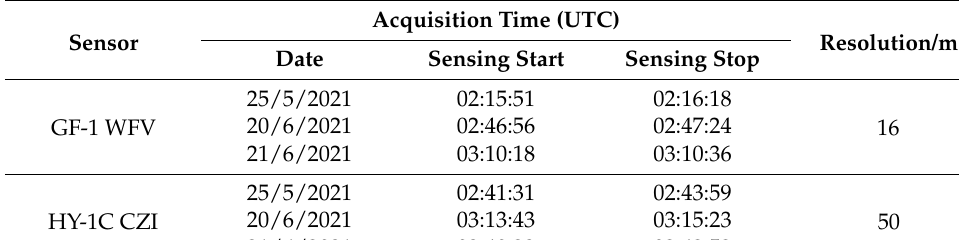
Table 3. Information of near-coincident GF-1 and HY-1C satellite images.